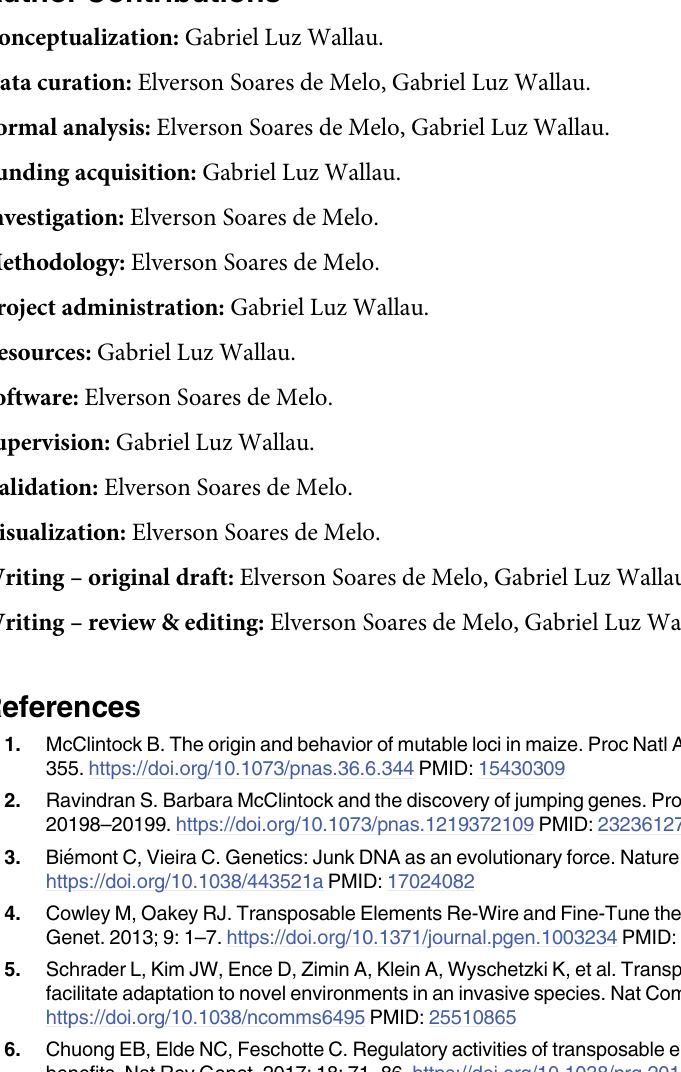
S8 Fig. Mosquito dataset follow VHICA assumptions. Histogram (A) and cumulative proba- bility curve (B) showing that the distribution of pooled residuals of linear regressions are Gaussian. Histograms (C, D, E, F) of some pairwise comparison were also showed, p-values of Kolmogorov–Smirnov test of normality confirm that we cannot reject normality. Relation between codon bias and dS can also be seen. (PNG) S9 Fig. Linearity relationship between dS and CUB. The plot shows the correlation of CUB of each pairwise comparison (Y axis) and synonymous substitution rate (X